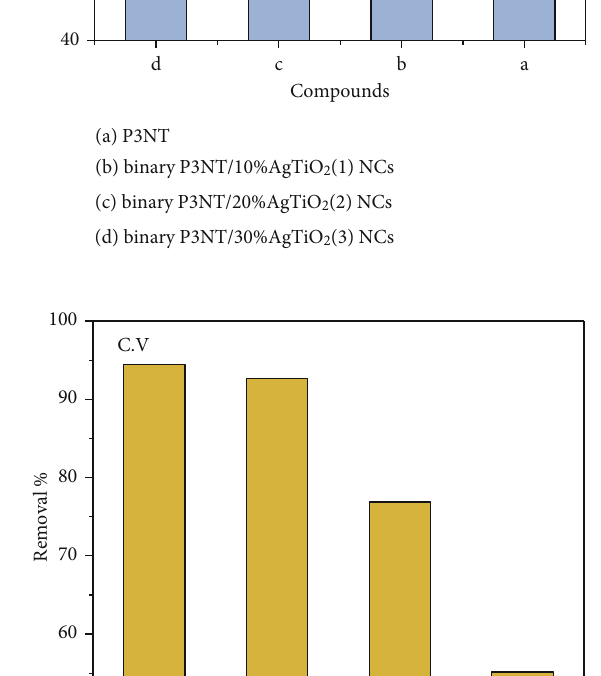
Figure 10. As proposed in conclusion, the endothermic nature of the adsorption process is suggested.